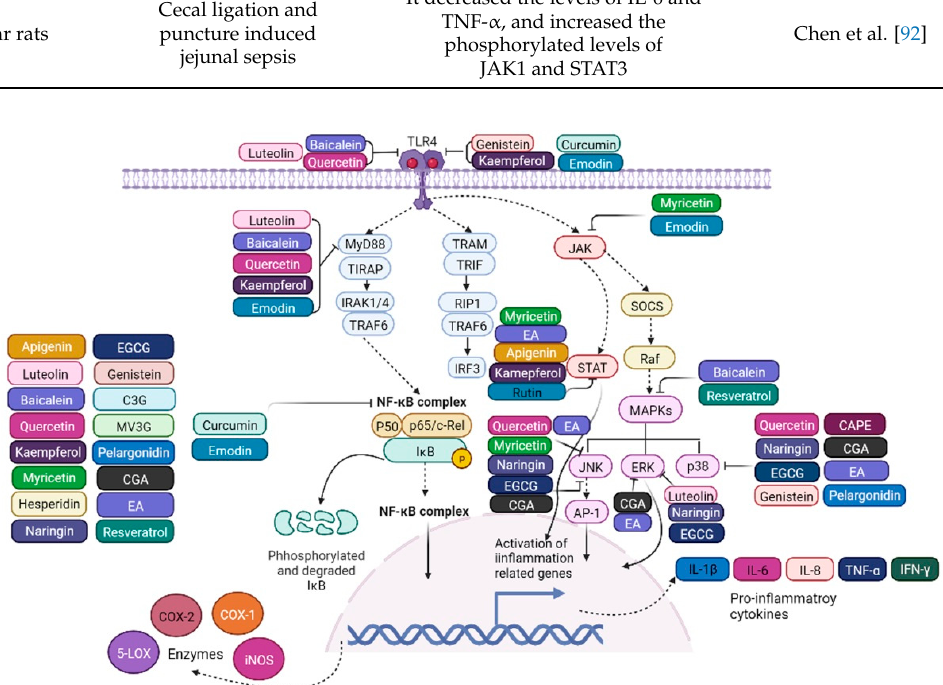
Figure 3. The regulatory inflammatory responses by which polyphenols affect the TLR4-mediated signaling pathway. EGCG, epigallocatechin-3-gallate; C3G, cyanidin-3-glucoside; MV3G, malvidin 3-glucoside; P3G, pelargonidin-3-O-glucoside; CAPE, caffeic acid phenethyl ester; CGA, chloro- genic acid. Inhibition.